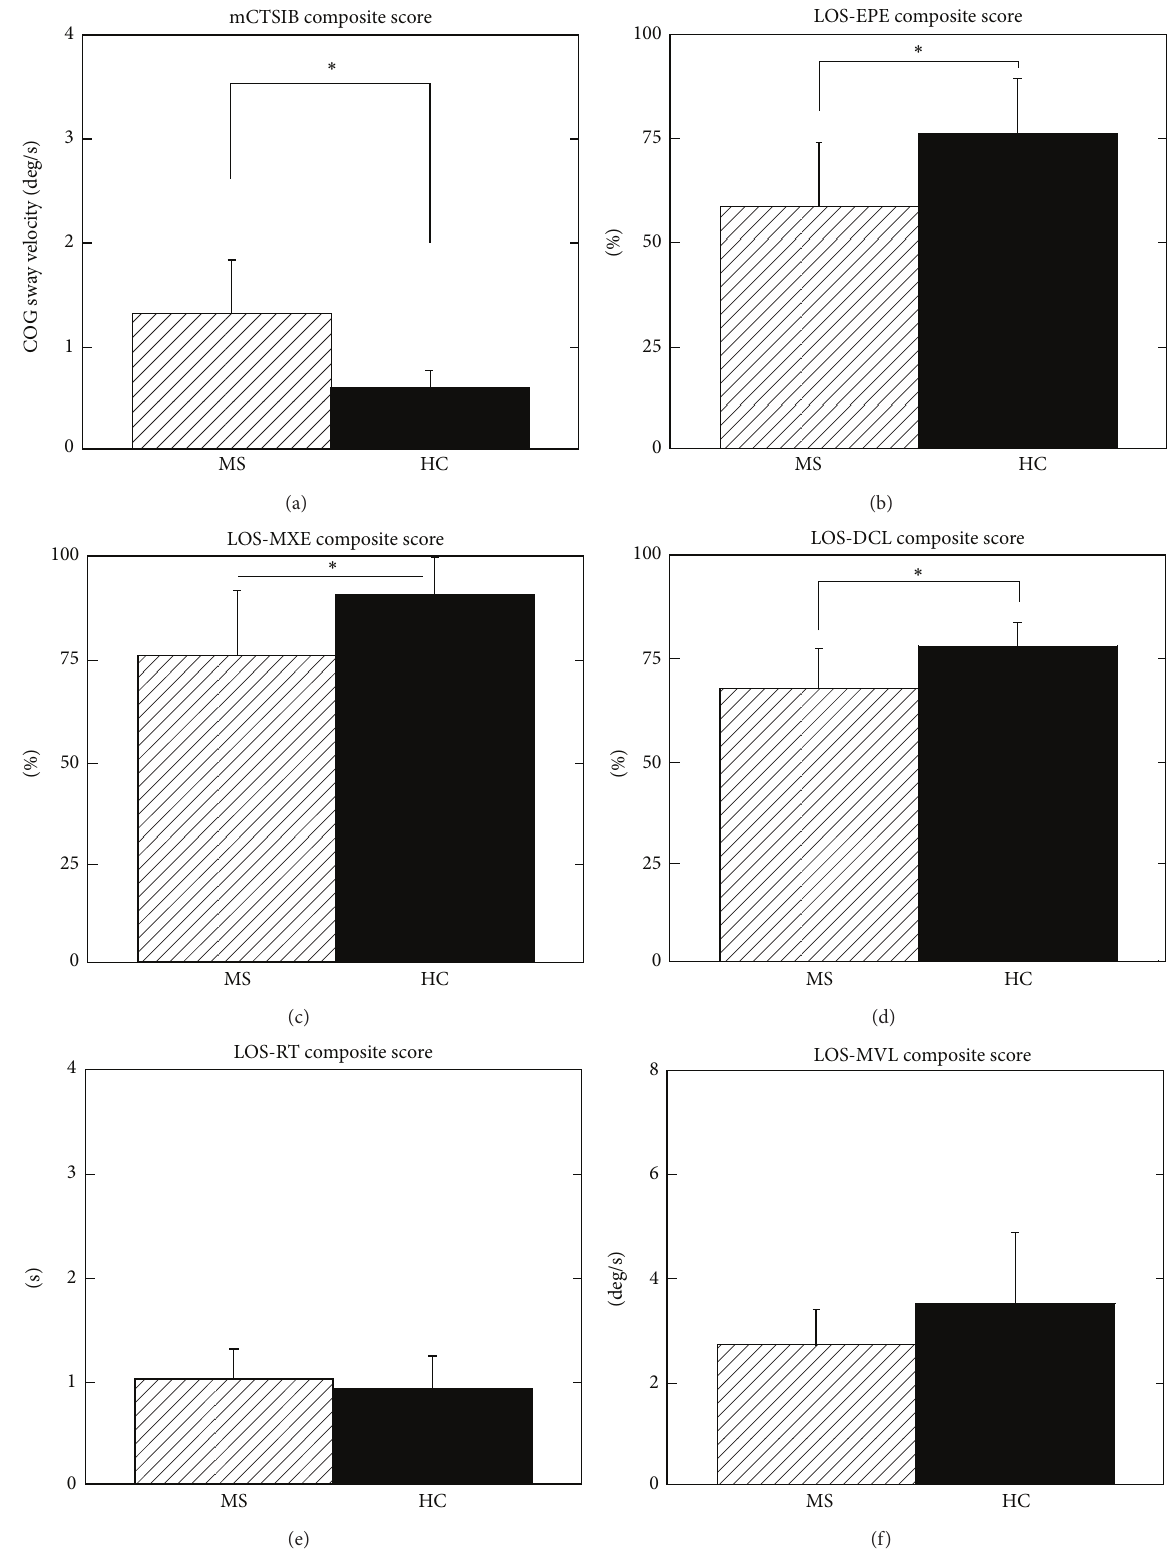
Figure 2: Modified Clinical Test of Sensory Interaction on Balance (mCTSIB) and Limits of Stability (LOS) test scores for the group of individuals with MS and healthy control (HC) subjects. COG: center of gravity, EPE: endpoint excursion, MXE: maximum excursion, DCL: movement directional control, RT: movement reaction time, MVL: movement velocity. ∗ denotes statistically significant differences at 𝑃 < 0.05